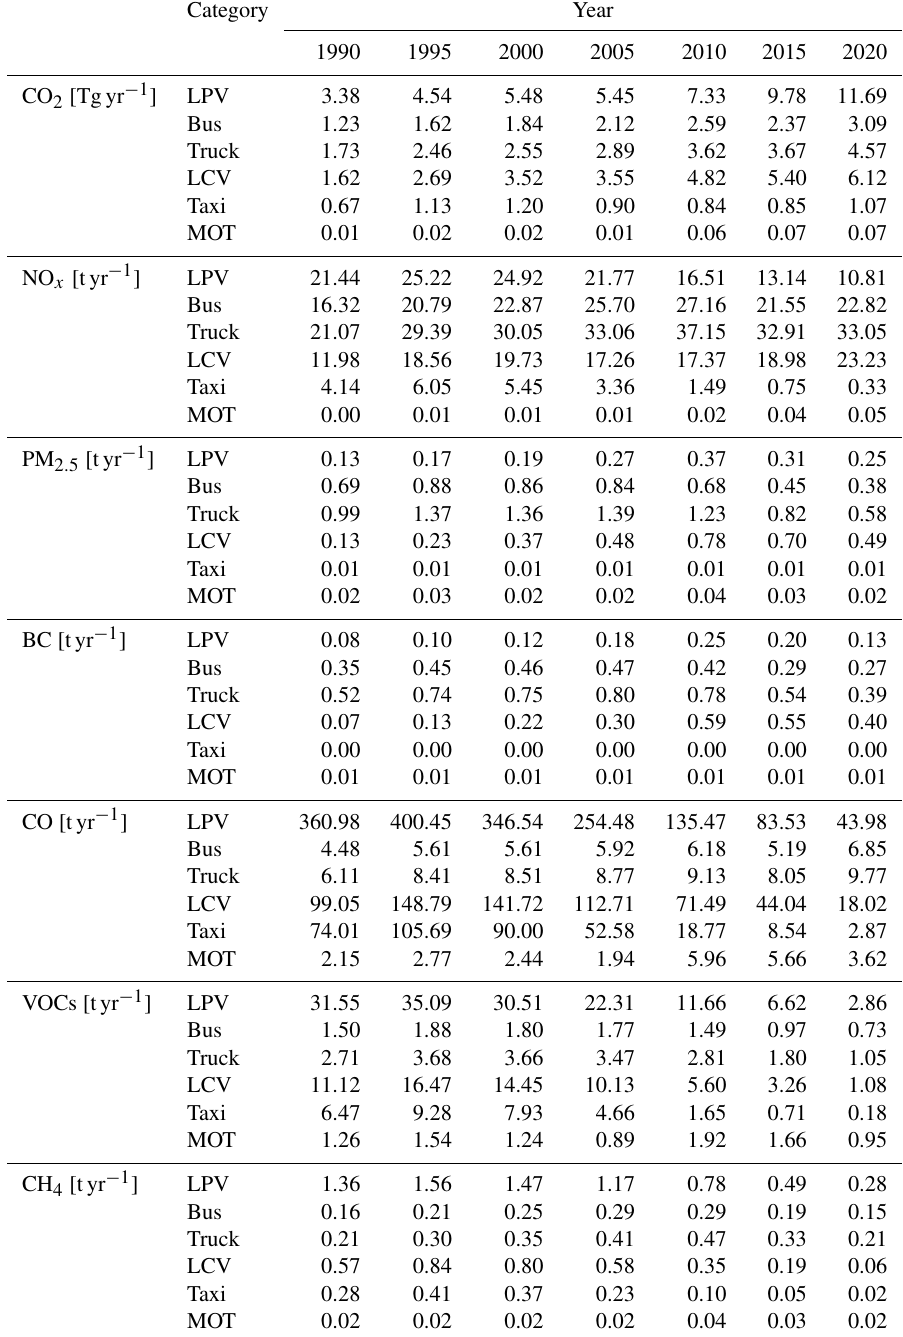
Table 7. Total annual exhaust emissions by vehicle type in Chile,